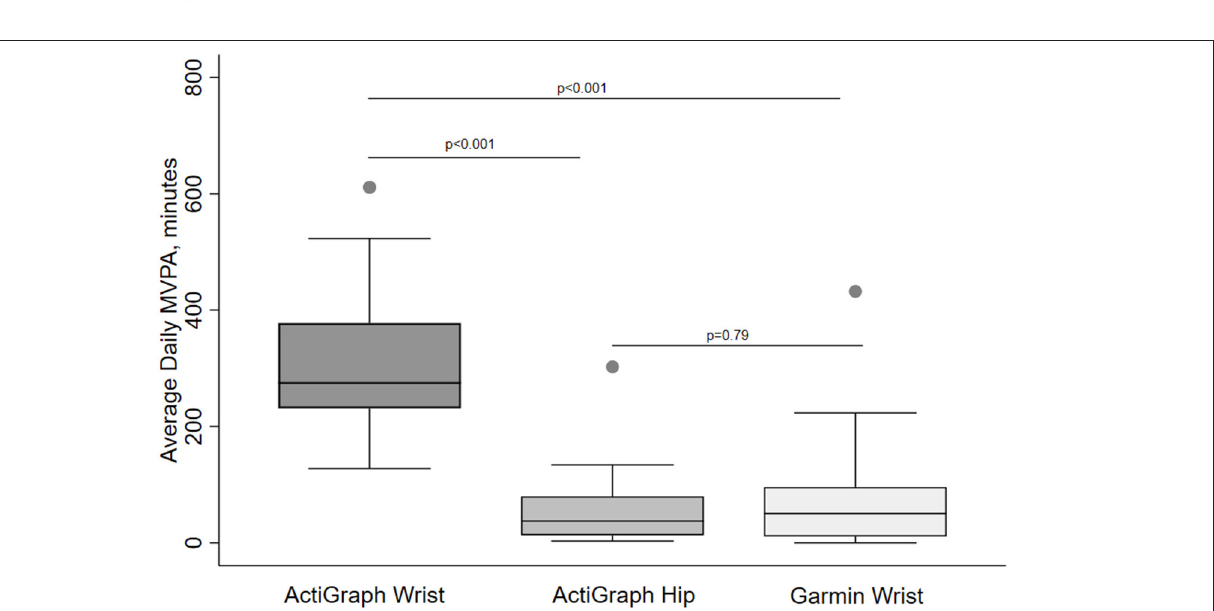
( Figure 3 ). The smallest difference in MVPA minutes between the Garmin device and the ActiGraph hip device was the comparison using vector magnitude counts for older